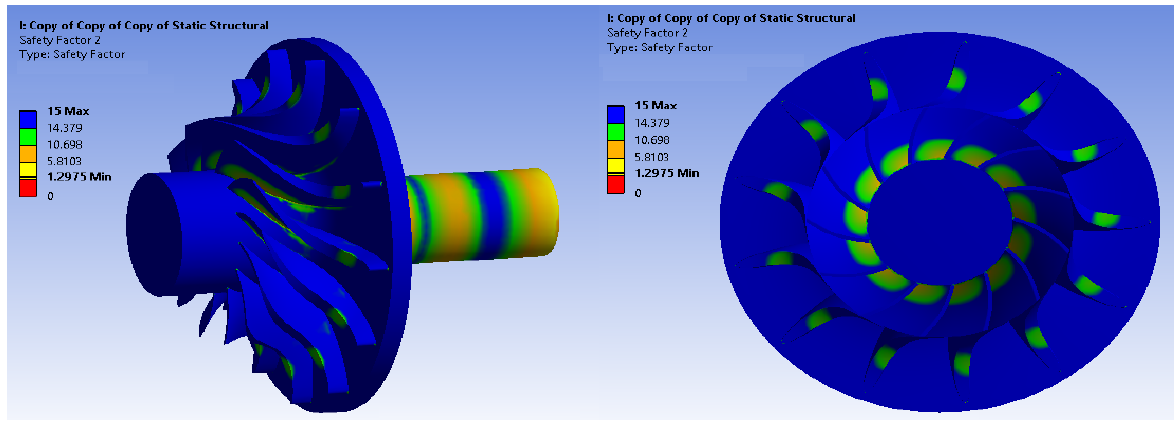
Figure 19. Safety factor for final global stress (R-134a).